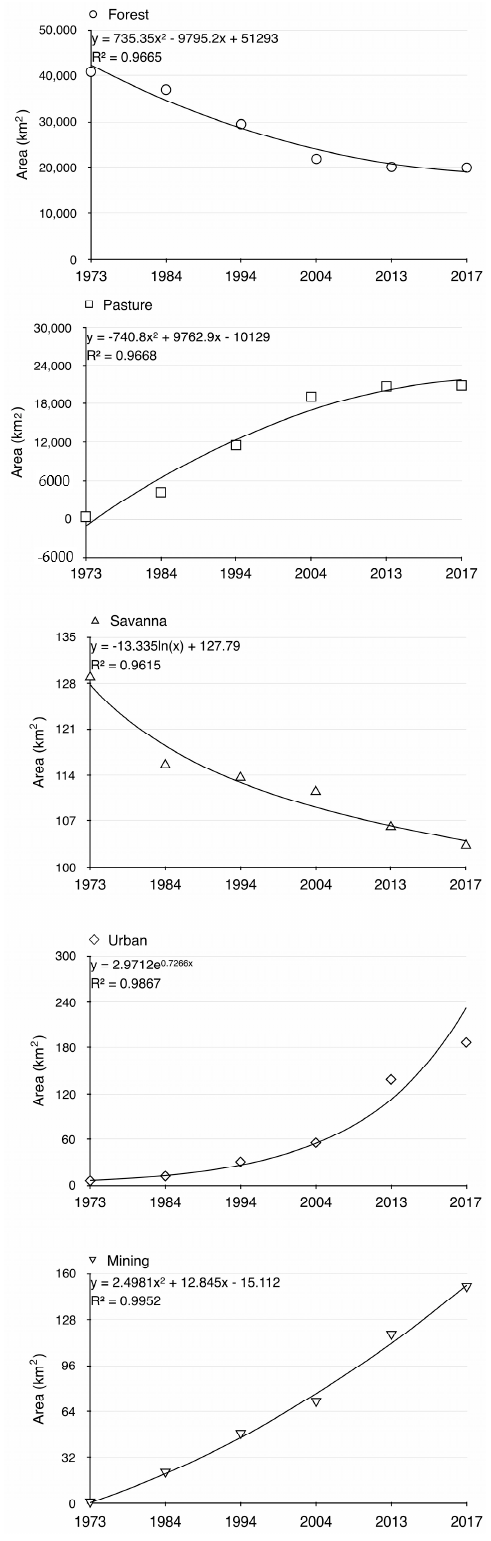
Figure 6. Land-cover and land-use area changes in the IRW from 1984 to 2017.